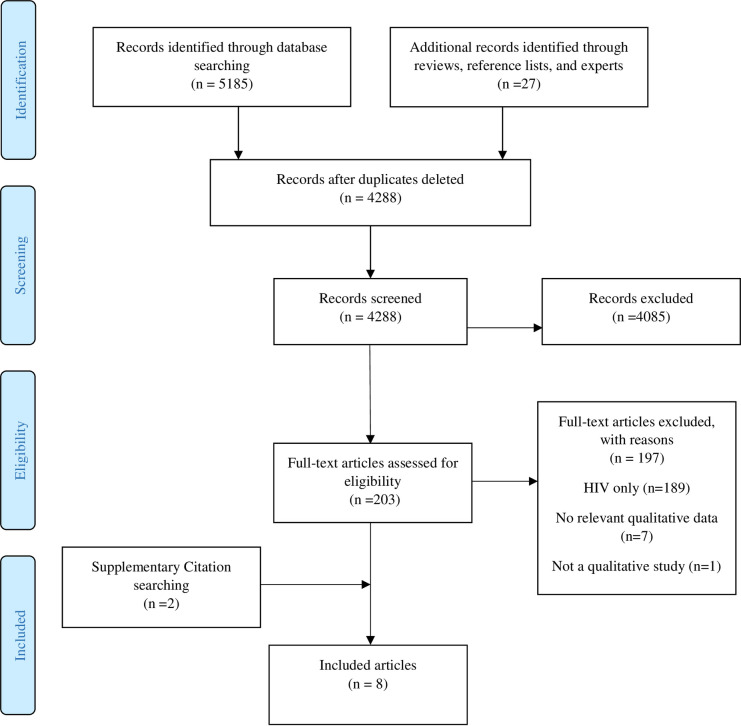
PRISMA flow diagram.